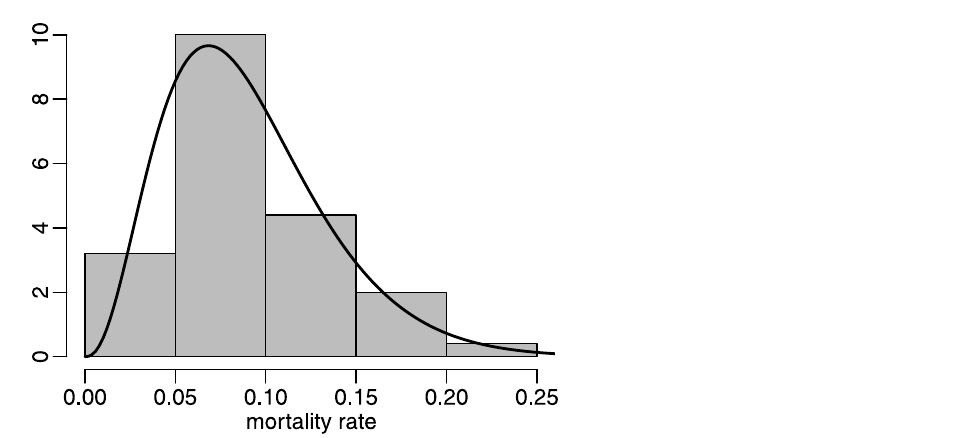
Fig 6. Histogram and fitted beta density, period 1, state data.